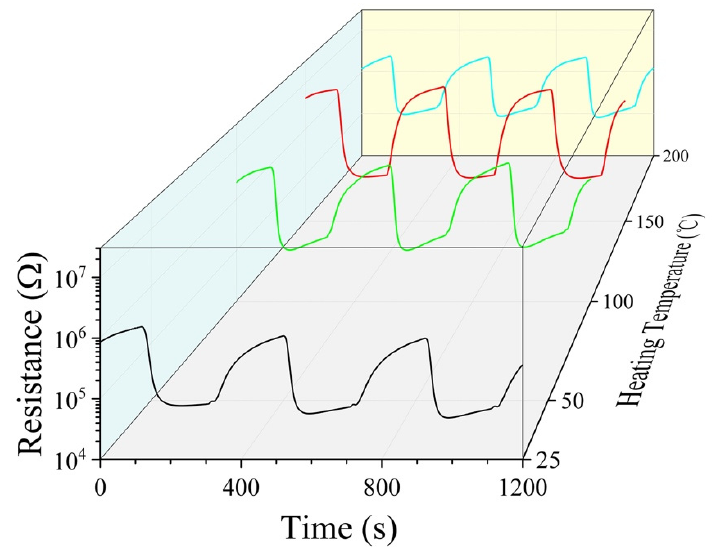
Figure 6. Resistance responses to 0.04% CO-20% O 2 -N 2 and recovery in air of 50 RH at room-temperature for a sample of 5 wt% Pd after 20 days of aging, and then being heat treated at a series of temperatures (100, 150, and 200 °C), separately.